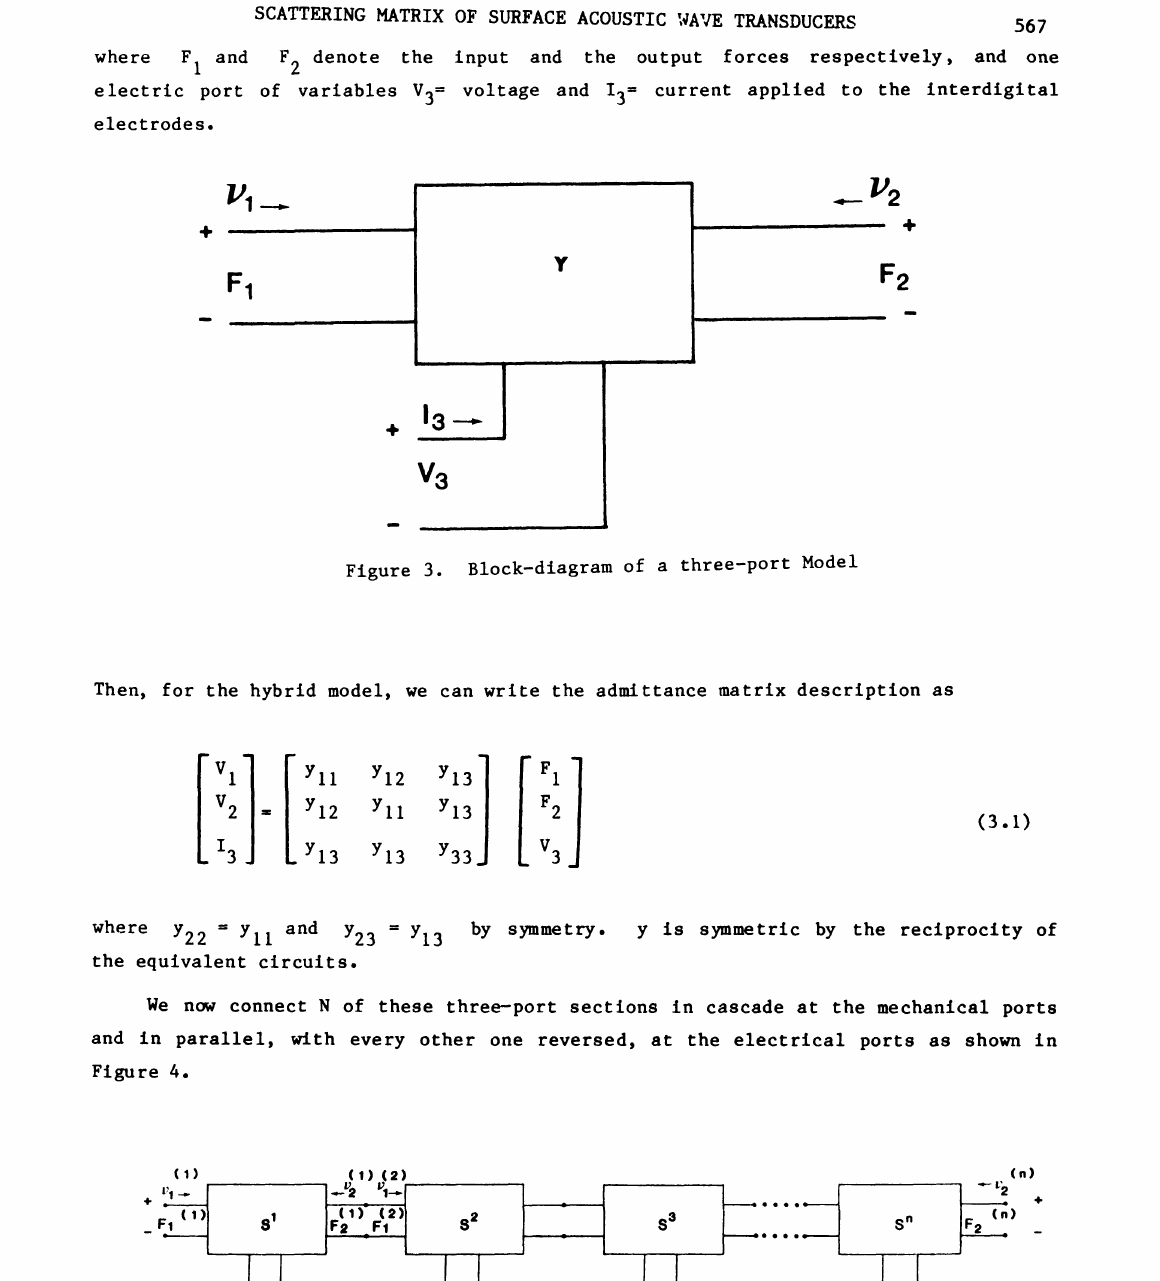
Figure 4. Cascaded one-electrode sections